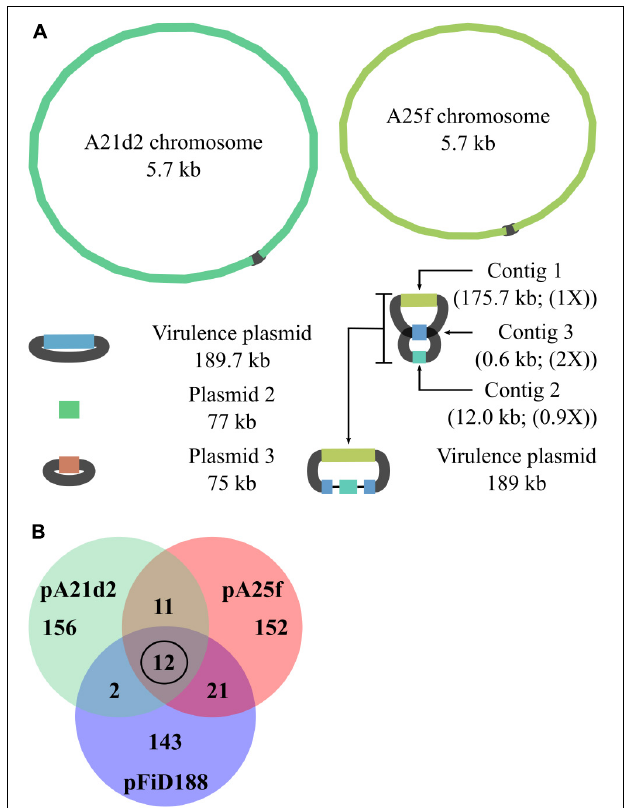
FIGURE 3 | Pathogenic strains A21d2 and A25f have novel virulence plasmids. (A) Graphs of hybrid assembled genome sequences of A21d2 and A25f. Sizes of the replicons are shown. For the pA25f, a predicted structure is presented. The relative depth of coverage of plasmid contigs is shown in parentheses. (B) Venn diagram of gene homolog similarity. The sequences of all genes on the plasmids of A21d2, A25f, and D188 were translated and clustered on the basis of